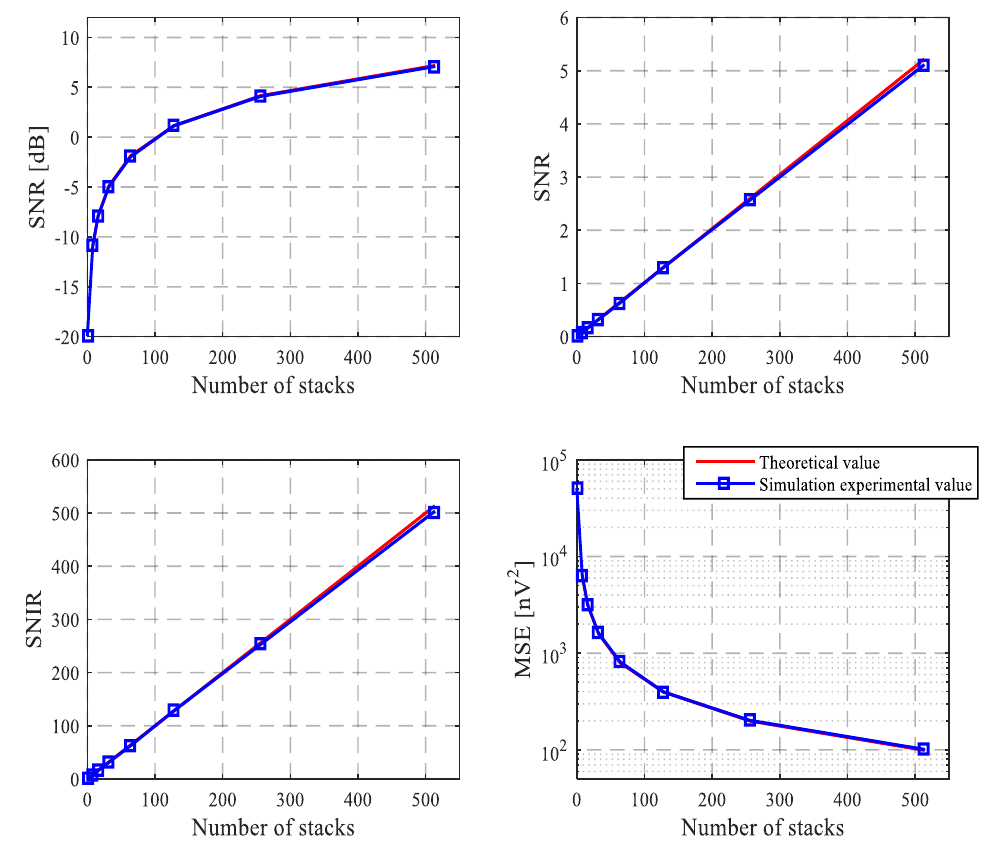
Figure 11. The curves of SNR, SNIR and MSE with increasing stacking times.